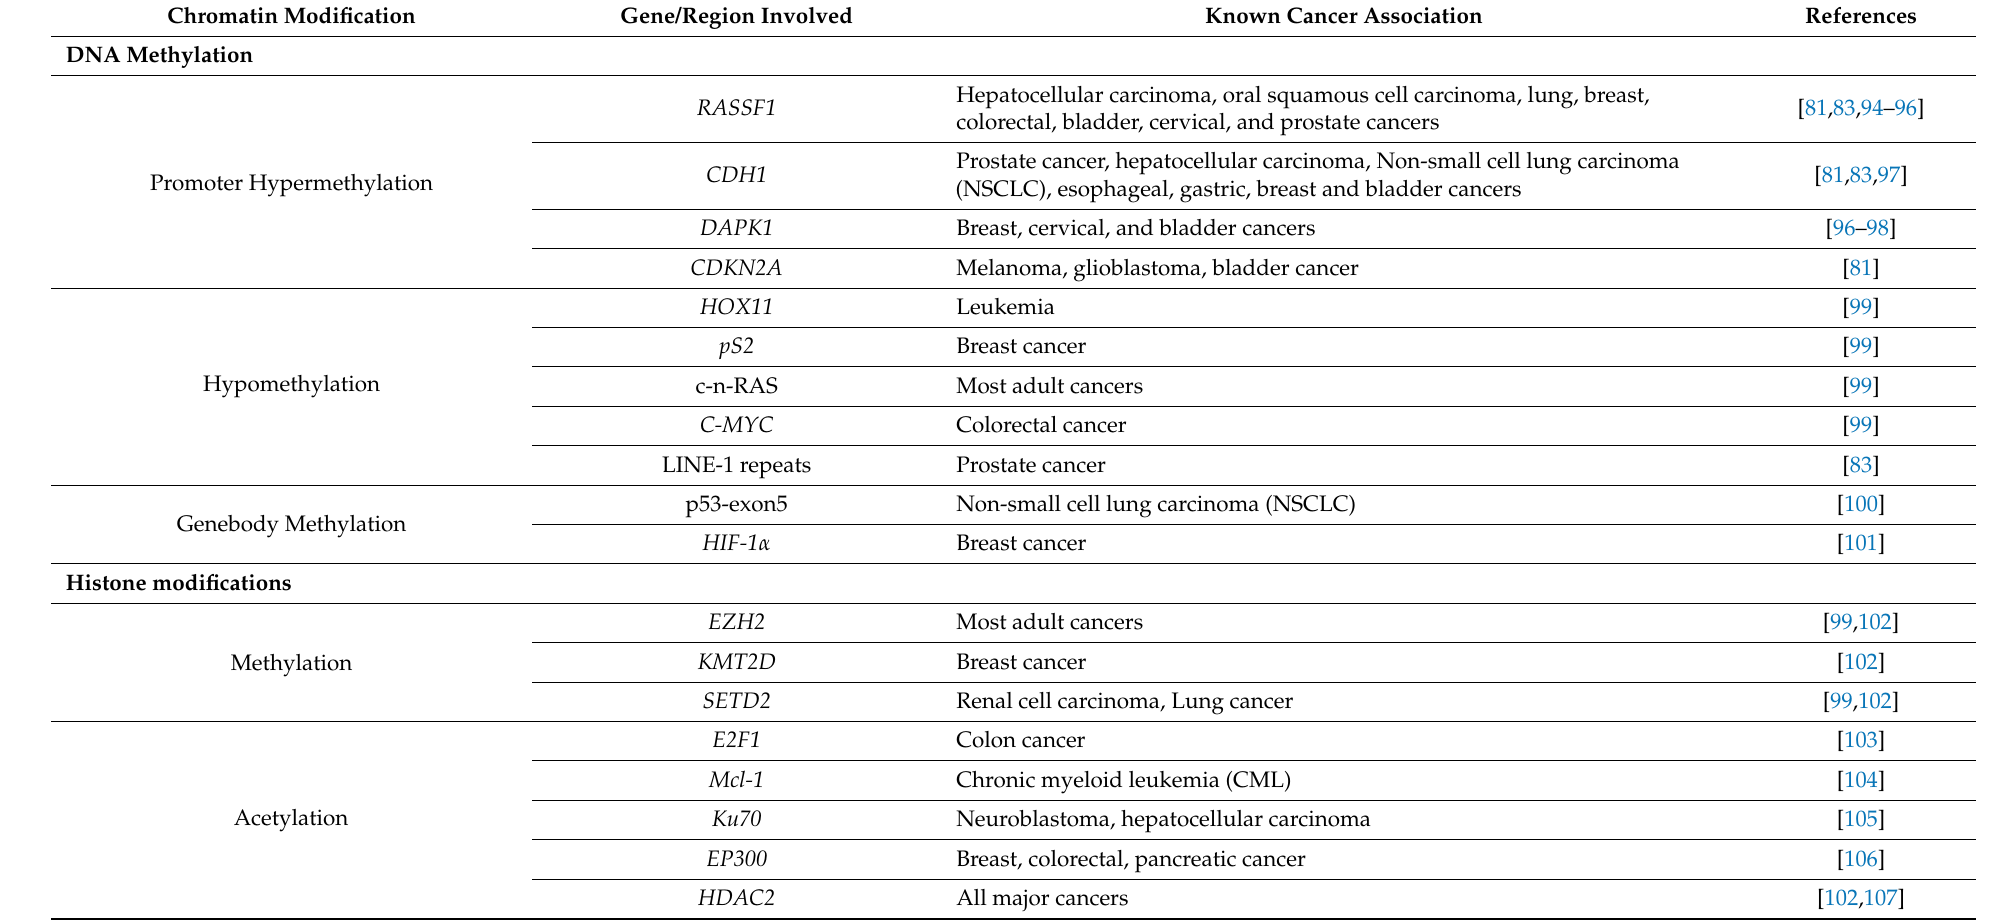
Table 2. Role of chromatin modifiers in cancer establishment and